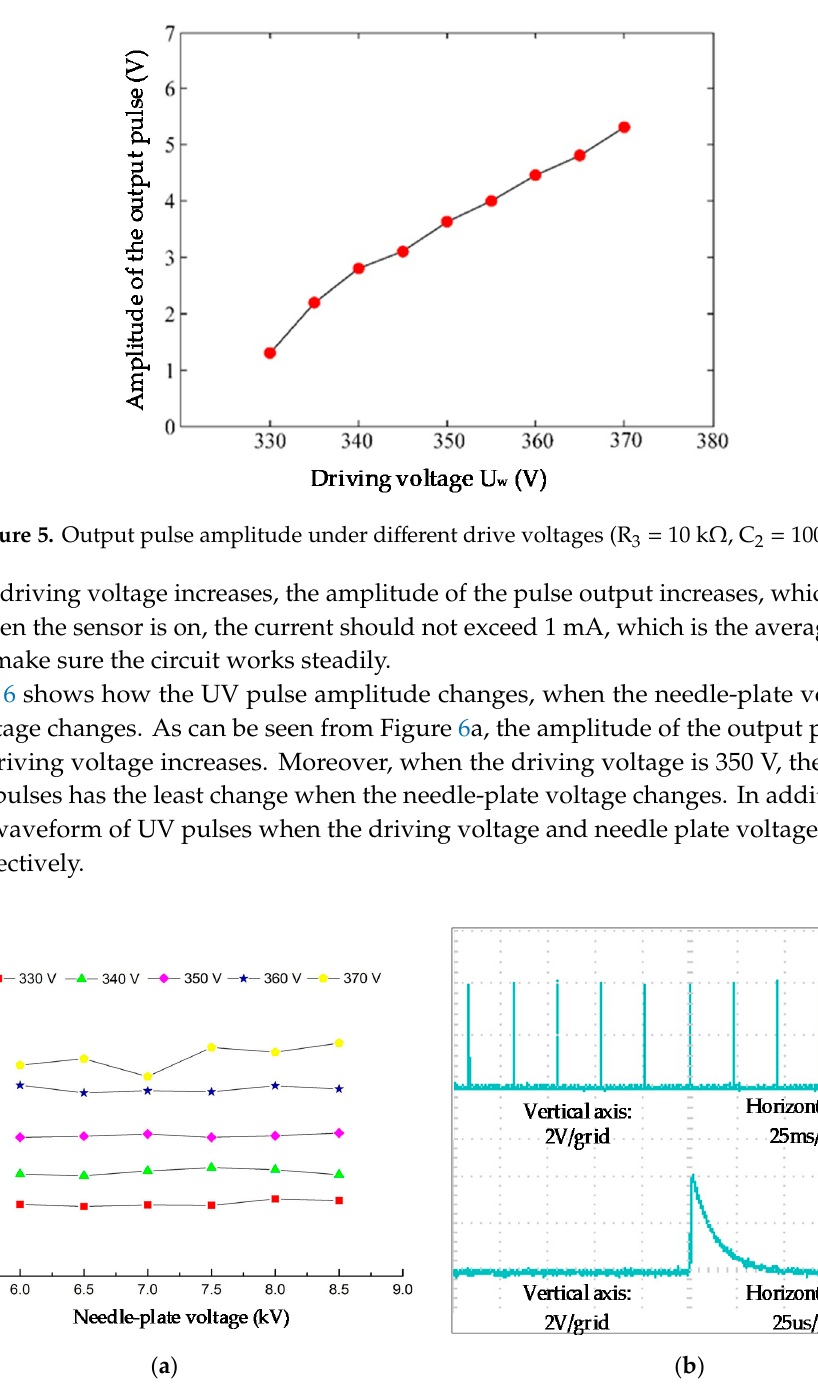
Figure 6. UV pulse amplitude and waveform after parameter optimization. ( a ) UV pulse amplitude under various driving voltages. ( b ) UV pulse voltage waveform.